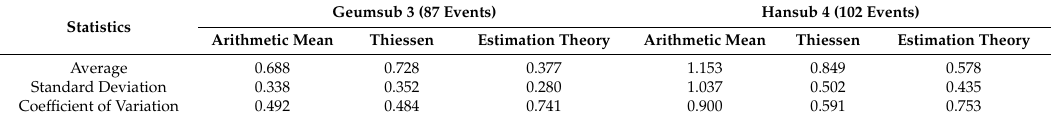
Figure 5. Comparison of the Estimation Error and Box Plot Depending on the Estimation Method of AAR. Table 7. Results of the Estimation Error Analysis Depending on the Estimation Method of AAR.